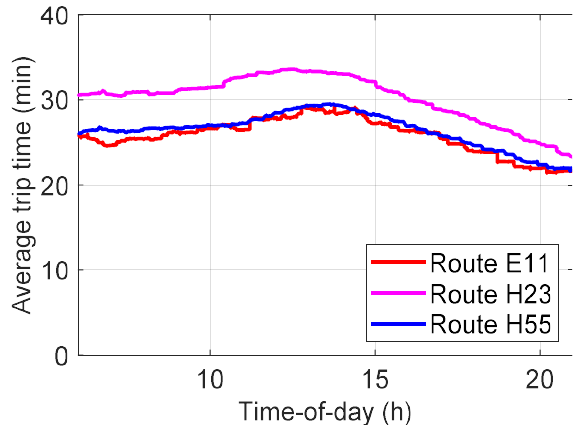
Figure 12. Route dependent trip time as a function of the time-of-day.